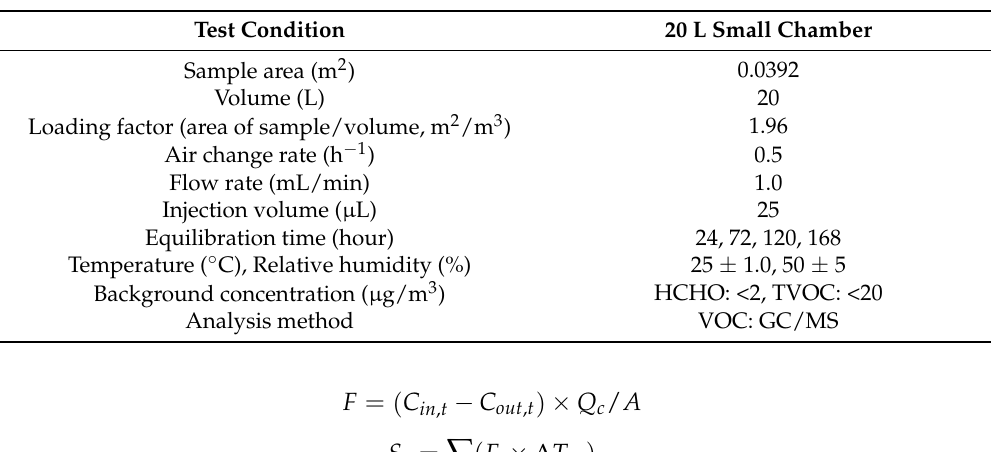
Figure 7. Manufactured mortar adhesive specimen: ( a ) MA/Ref. and ( b ) MA/x3. Table 3. Test conditions in the 20 L small chamber